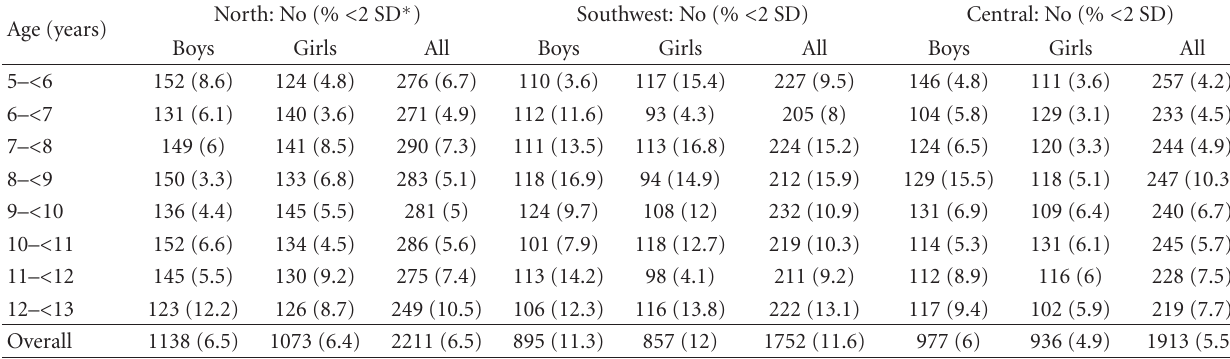
Table 1: Regional prevalence of short stature in school-age children.